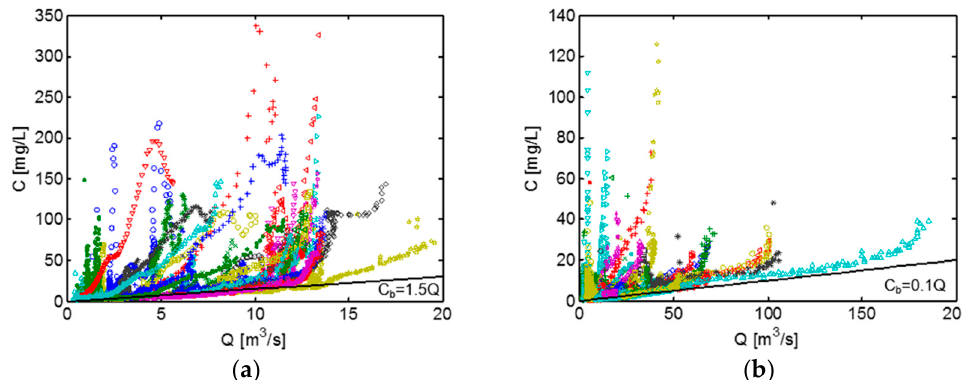
Figure 2. Fine sediment concentration data during falling limb recession of each flood event for Owenabue from 15 September 2009, to 15 September 2010 ( a ), and Bandon from 10 February 2010, to 9 February 2011 ( b ). The symbols with different colors and shapes represent different flood events.